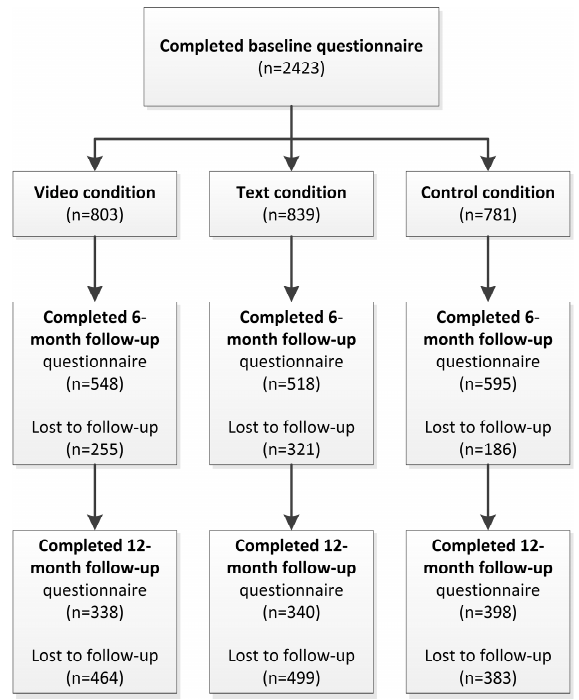
Figure 1. Flowchart of assessments.